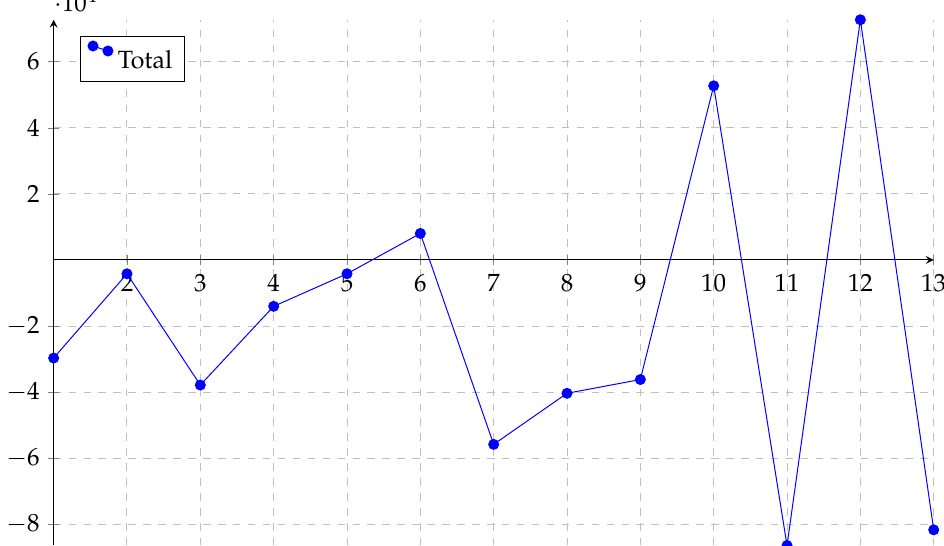
Figure 4. Differences in the amounts of financial compensation for two sets of substations.